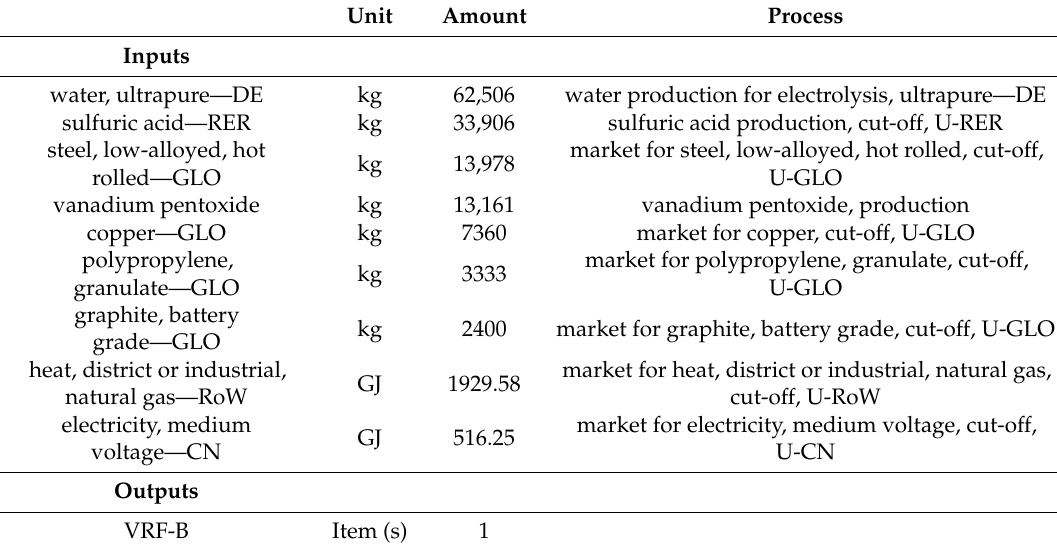
Table A21. Manufacturing, VRF-B.